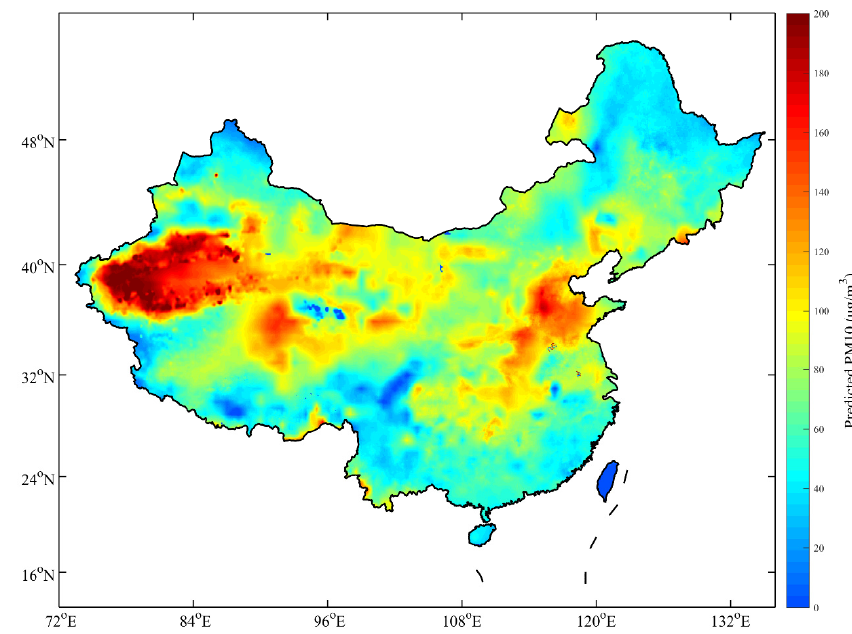
Figure 8. Spatial distribution of annual average PM 10 mass concentrations for the GWR model.